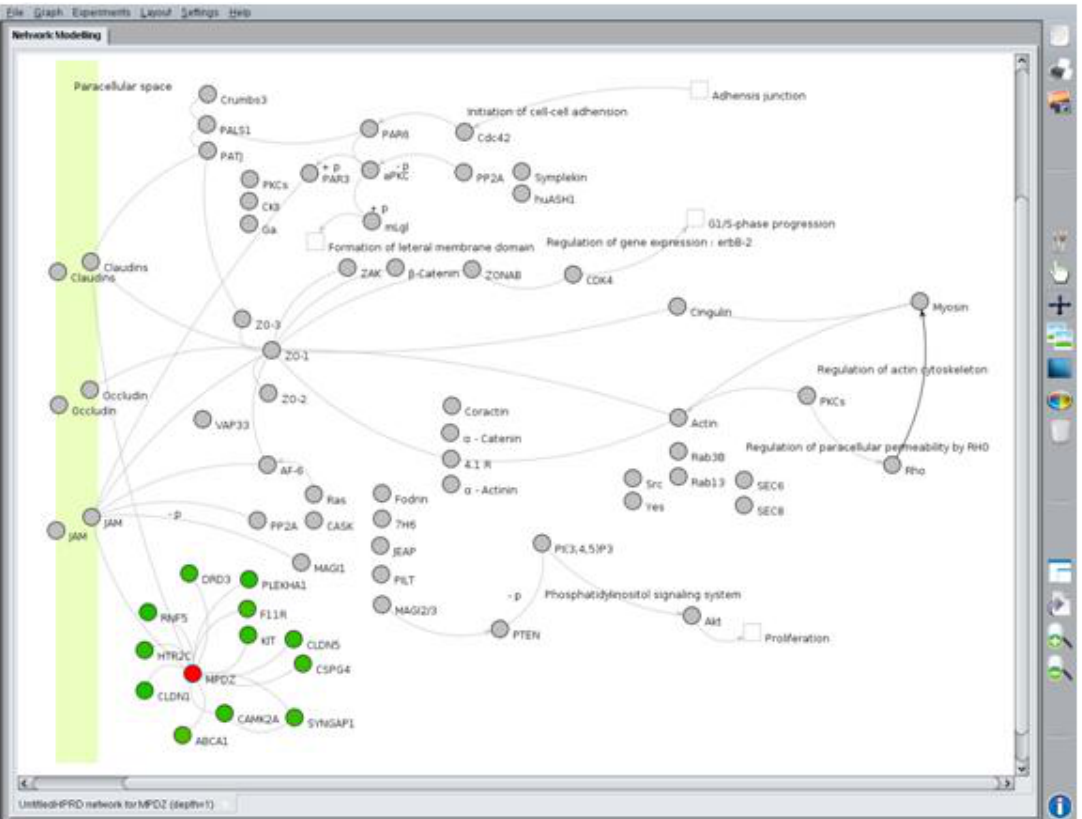
Figure 2: Visualization of the Tight junction signaling pathway (hsa04530) from KEGG by VANESA. The place marked red is the relevant protein MPDZ on the microarray